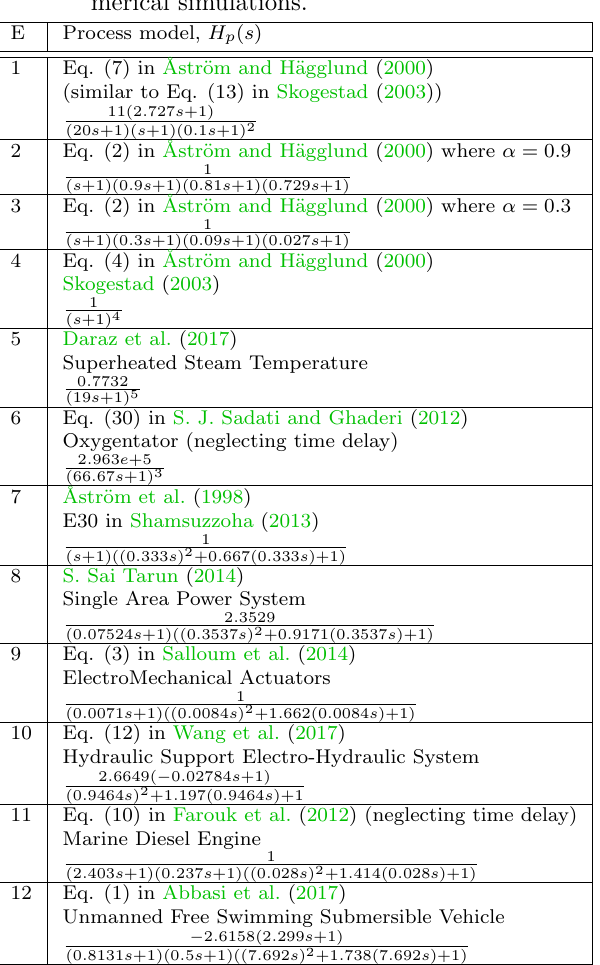
Table 2: Shows the test batch, i.e. the motivated pro- cess model examples (Es1-12) used in the nu- merical